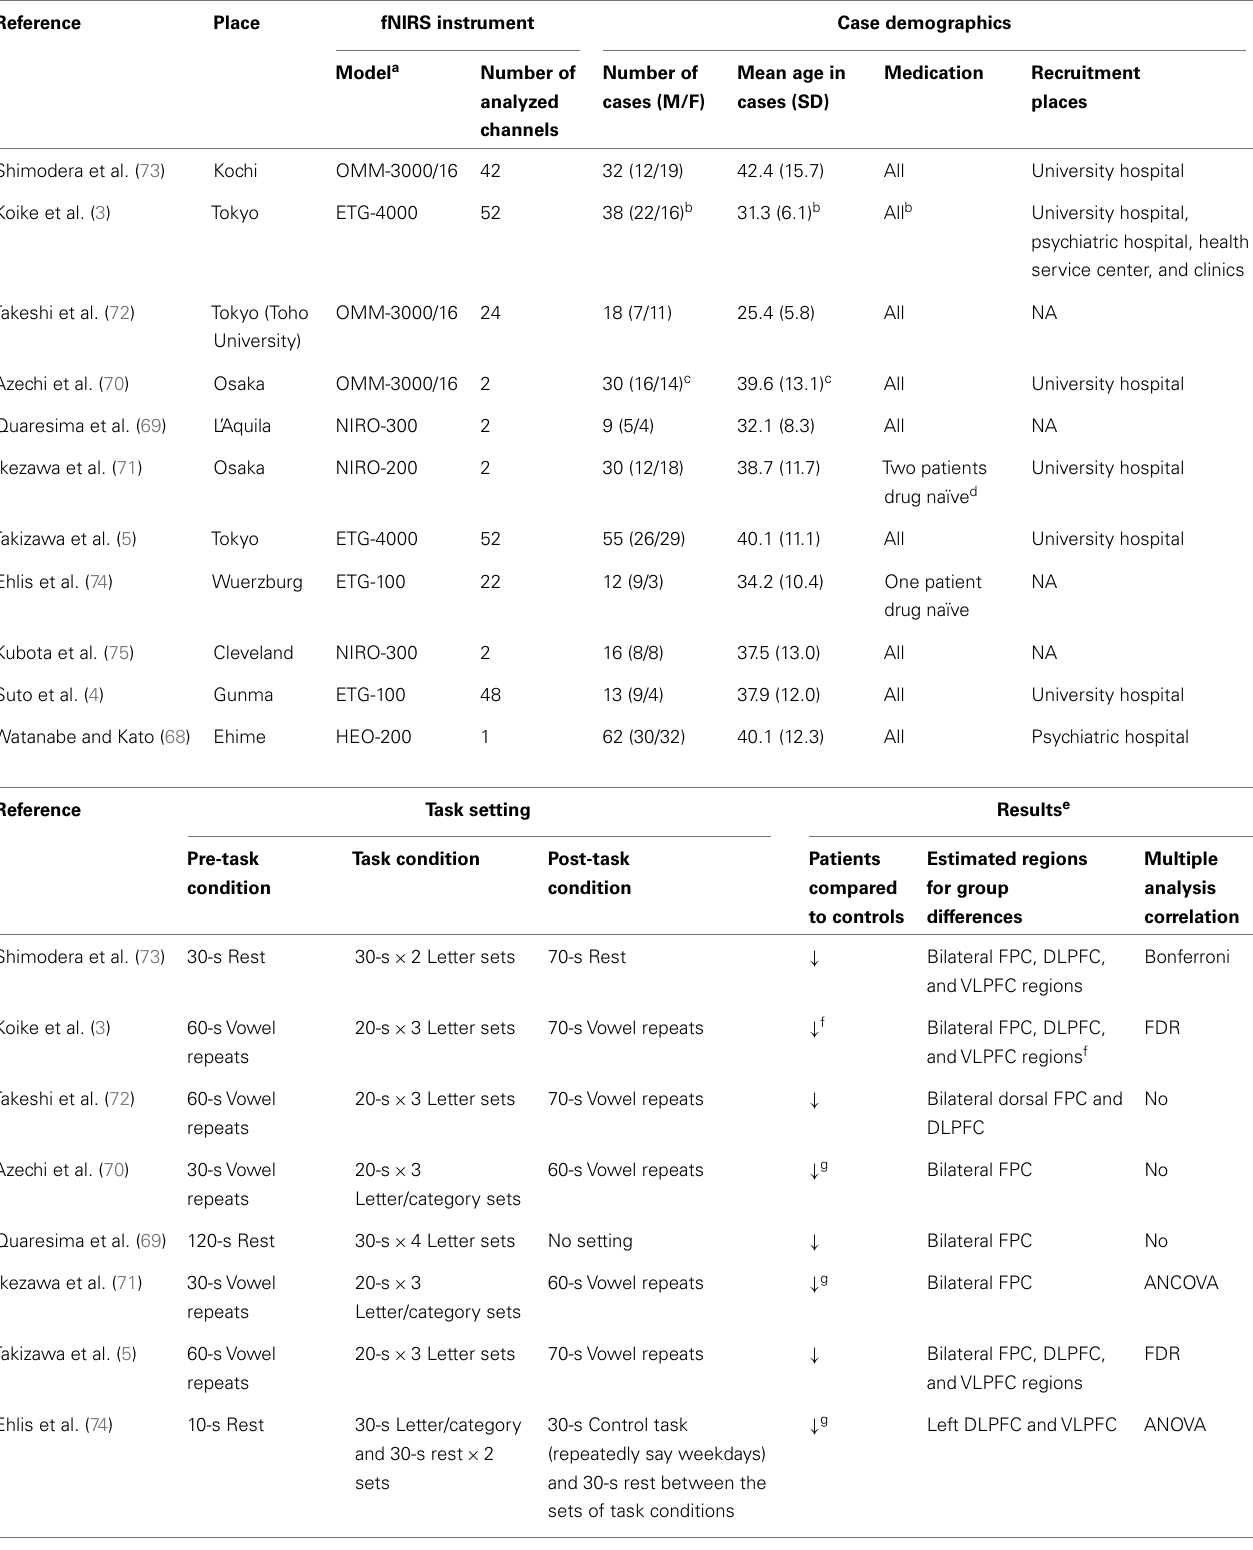
Table 2 | Previous fNIRS studies in schizophrenia using verbal fluency